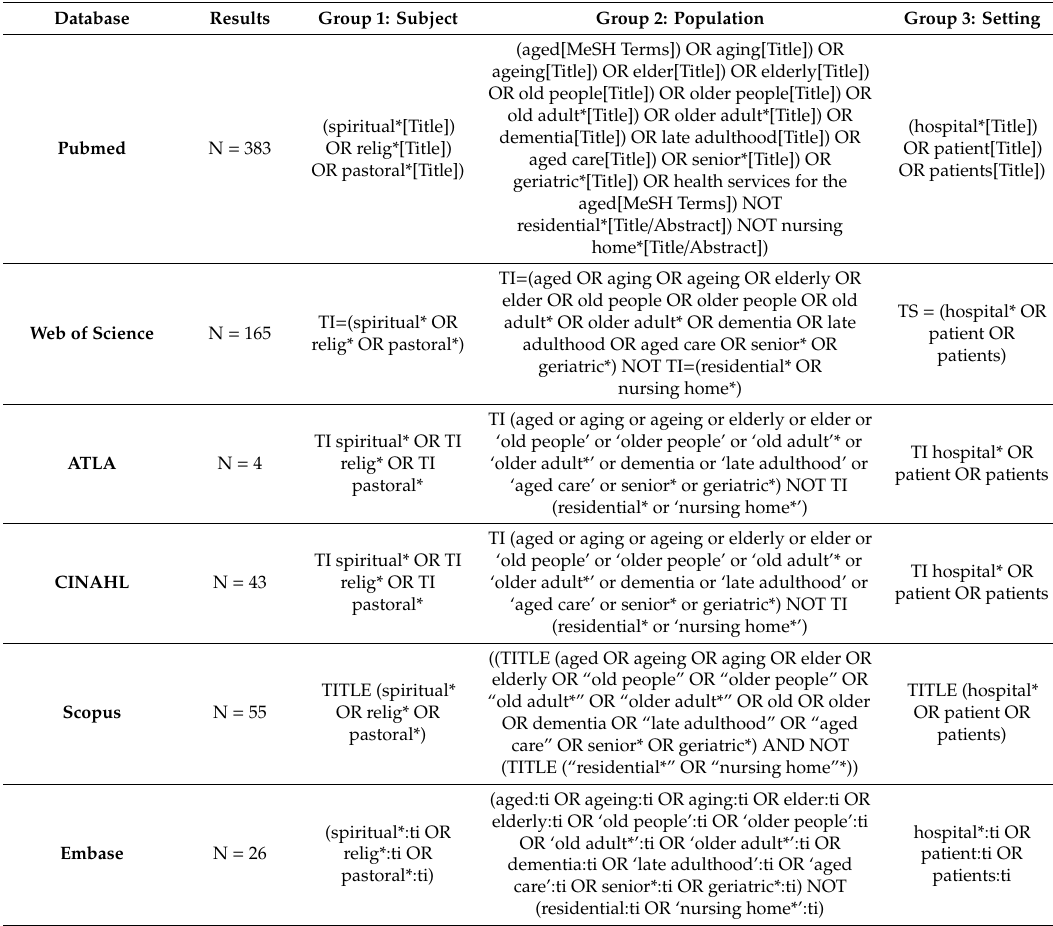
Table 1. Overview of the search strategy: database, results and search terms. The search terms were combined in each database. TI = Title, TS =